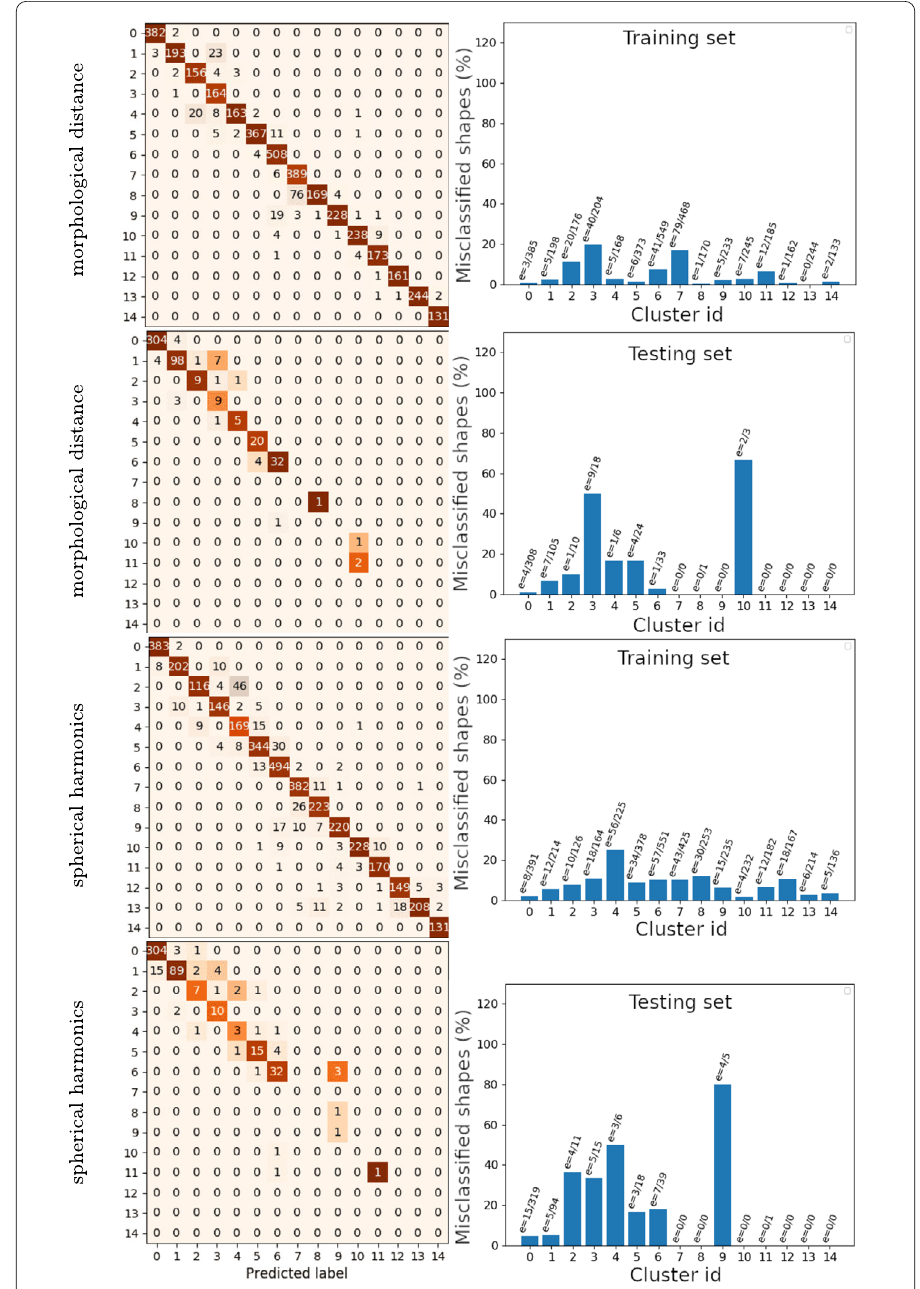
Figure 17 Left column: confusion matrices for the training (rows 1, 3) and testing sets (rows 2, 4) showing the true Grassmann clustering label vs. the label predicted by the neural network using the morphological (rows 1, 2) and spherical-harmonics distance (rows 3, 4). Right: percentage of misclassified shapes in each cluster after data augmentation